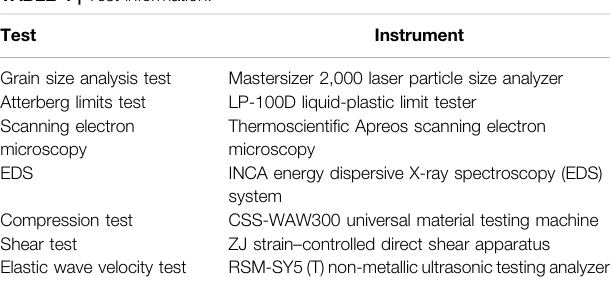
TABLE 4 | Test information. Test